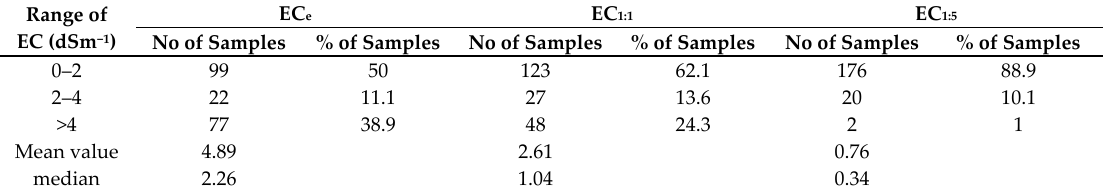
Table 3. The numbers of EC e , EC 1:1 and EC 1:5 values are shown in three classes together with their respective mean and median values of the whole lot of soil